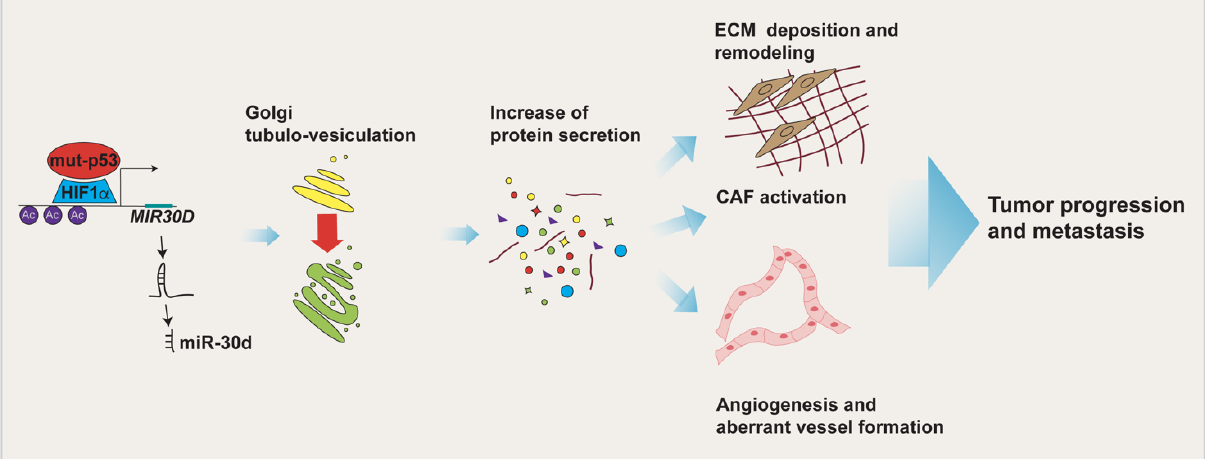
FIGURE 1: Impact of the mut-p53 secretome on the TME. mut- p53 in cooperation with HIF1α is able to bind MIR30D promoter and activate the expression of miR- 30d. By targeting the diacylglycerol kinase ζ (DGKZ), miR -30d fosters diacylglycerol DAG signaling in the Golgi Appa- ratus, causing morphological and functional alterations (i.e. Golgi tubulo-vesiculation), responsible for the increase in total protein secre- tion.The mut-p53 driven secretome, including soluble factors and extracellular matrix (ECM) components, induces tumor cell invasion and migration, angiogenesis, alteration of mechanical properties of the ECM and fibroblasts activation. Altogether these TME features sustain tumor progression and